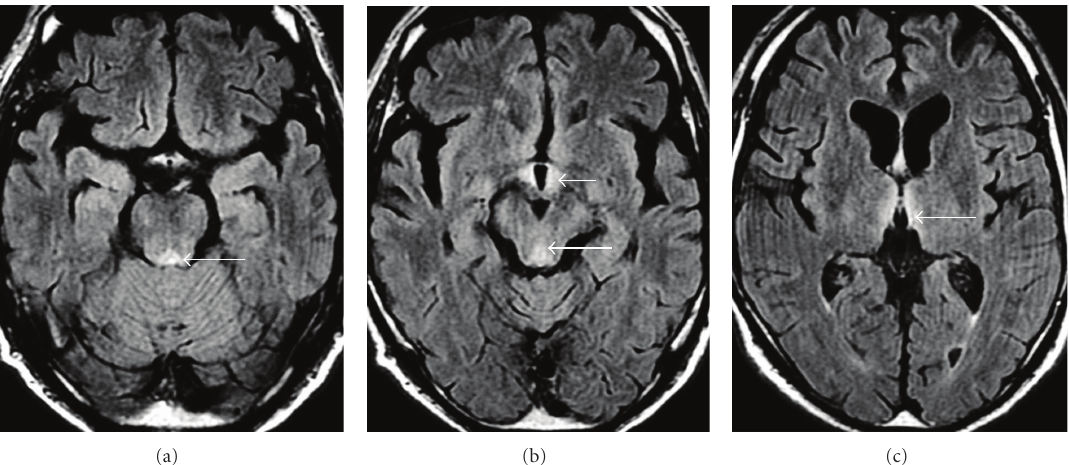
Figure 1: MRI-FLAIR images of the brain showed symmetrical high-intensity lesions (arrows) in the floor of the fourth ventricle (a), periaqueductal grey matter (b), hypothalami (b), and medial thalami (c).